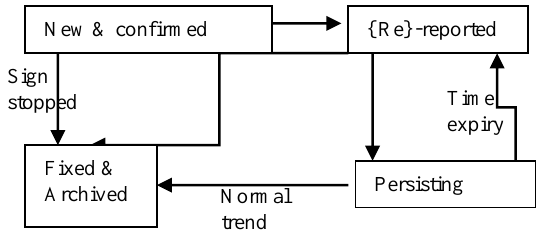
Figure 5 . State transition diagram of the